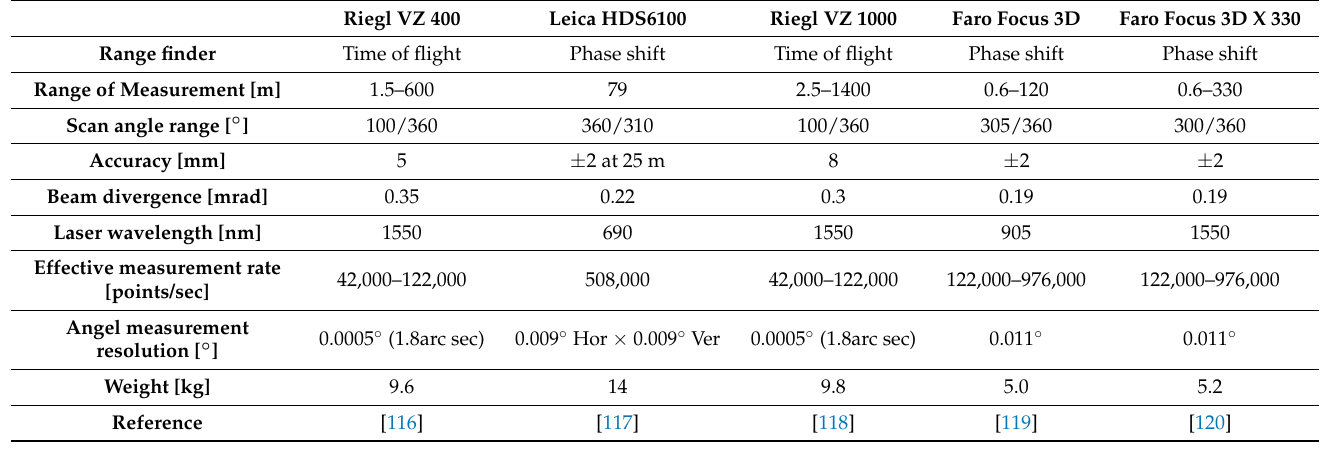
Table 2. Commonly used terrestrial laser scanners.